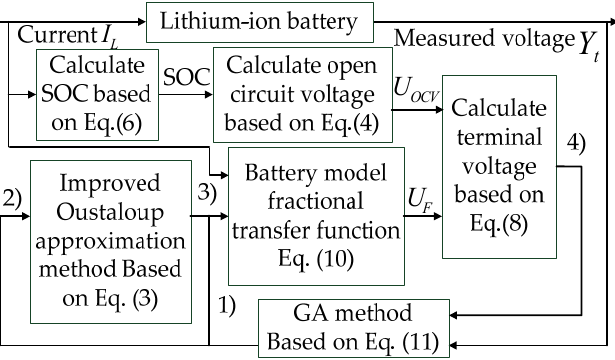
Figure 2. GA ‐ based parameters identification framework design for fractional ‐ order model. Figure 2. GA-based parameters identification framework design for fractional-order